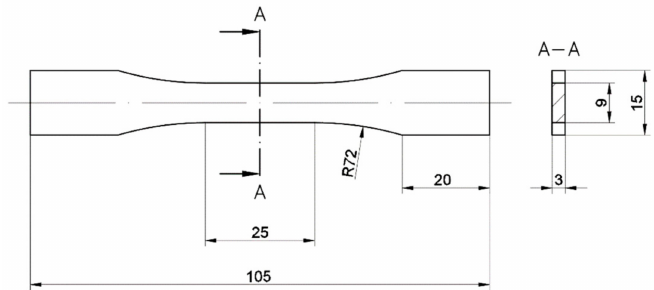
Figure 1. ASTM E466 96 samples